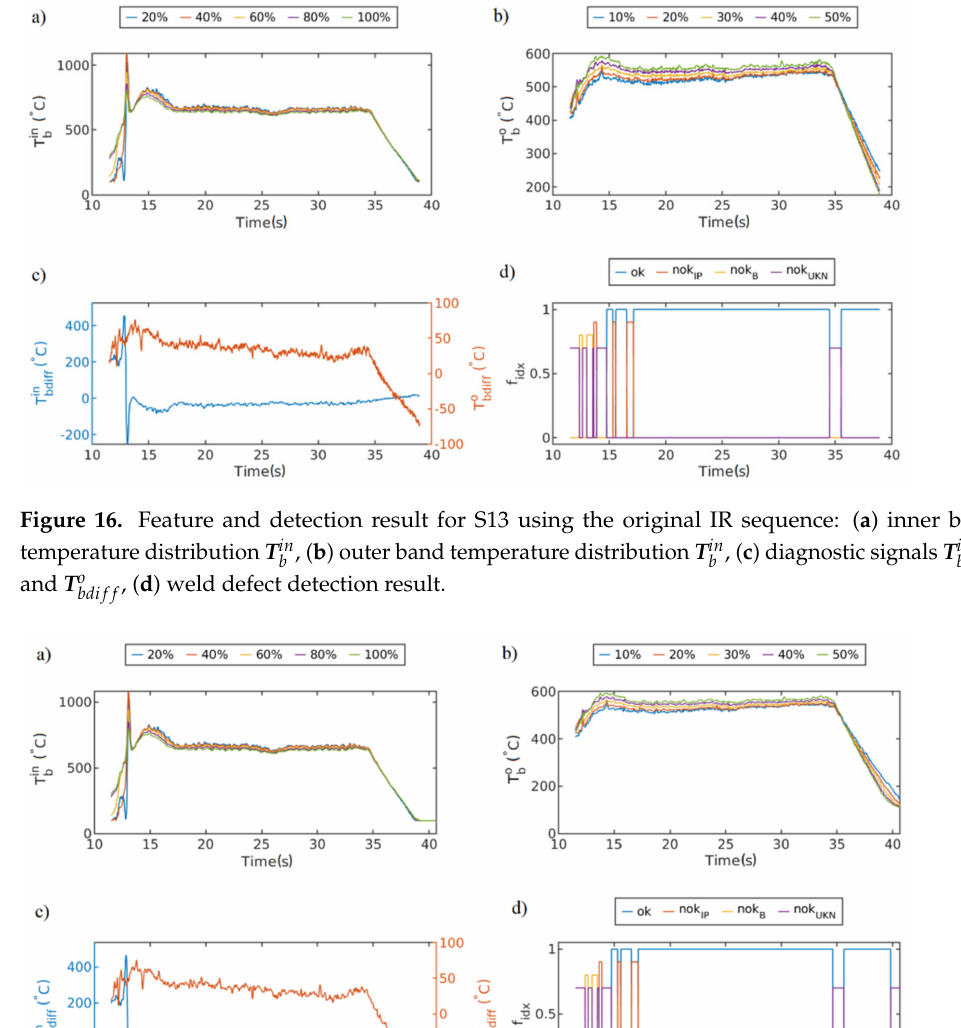
Figure 17. Feature and detection result for S13 using the interpolated IR sequence obtained using cubic interpolation with the interpolation factor = 2: ( a ) inner band temperature distribution T in , ( b ) outer band b temperature distribution T in , ( c ) diagnostic signals T in and T o , ( d ) weld defect detection b bdif f bdif f